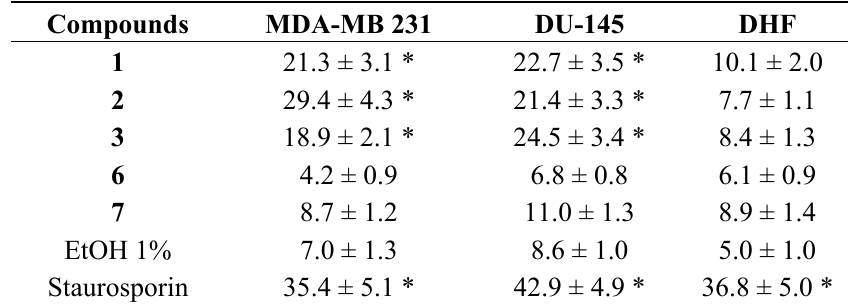
Table 1. Percentage of condensed and/or fragmented nuclei after treatment with compounds 1 – 3 , 6 , 7 , ethanol and staurosporin (* p <